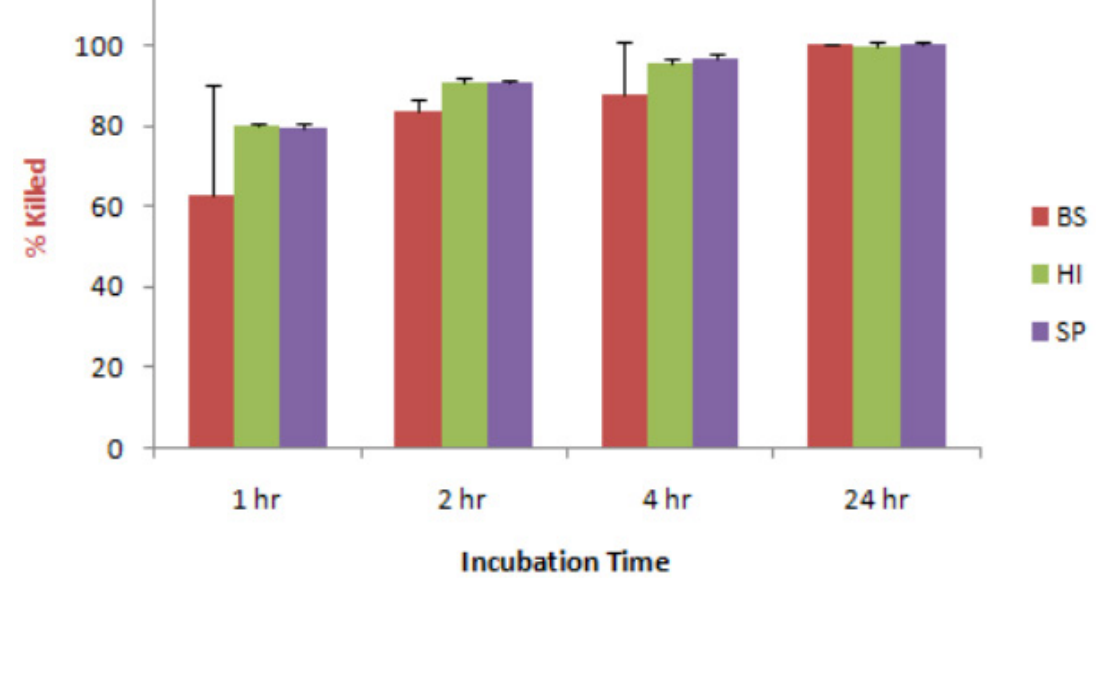
Figure 4. Effect of CLO-vapor on dried bacteria. 100 µL each bacterium were air dried on glass slides, and exposed to the vapor of CLO in a glass vessel, at 22 ºC. The bacteria were then reconstituted in saline and assayed for CFU, in comparison with unexposed bacteria. BS = B. subtilis , HI = H. influenzae , SP = S.